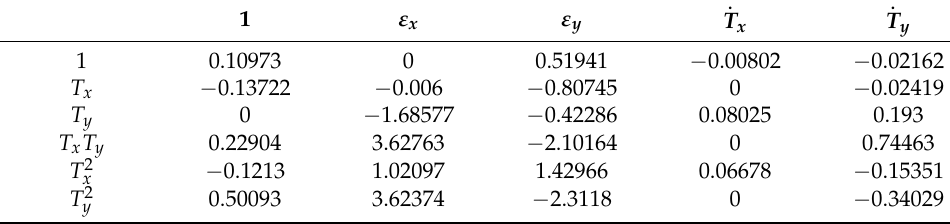
Table 4. Fitting results for (cid:101) K tx , ty